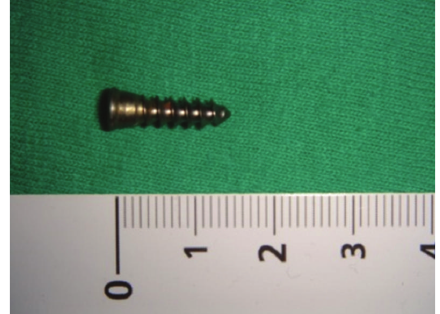
Figure 3: The screw after the removal, length